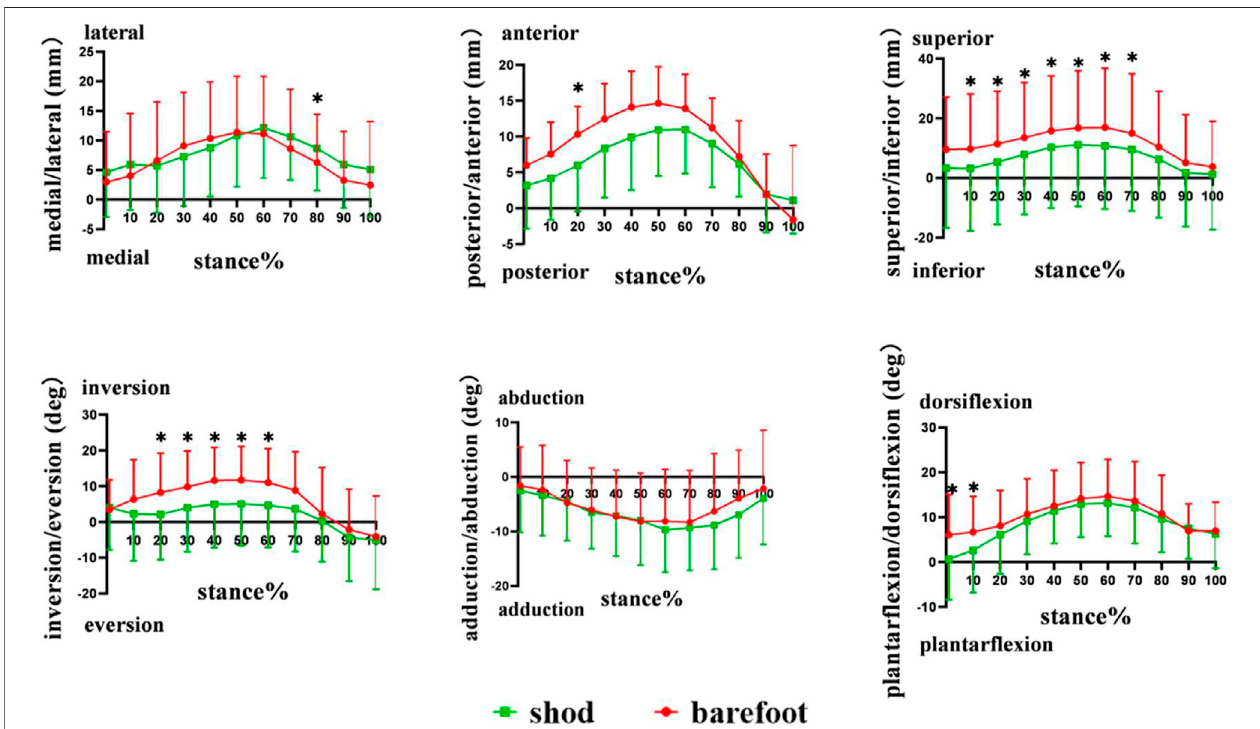
FIGURE 6 | 6DOF movement of the fi rst metatarsal relative to the calcaneus during the stance phase. *: signi fi cant differences between the shod and barefoot conditions, p < 0.05.